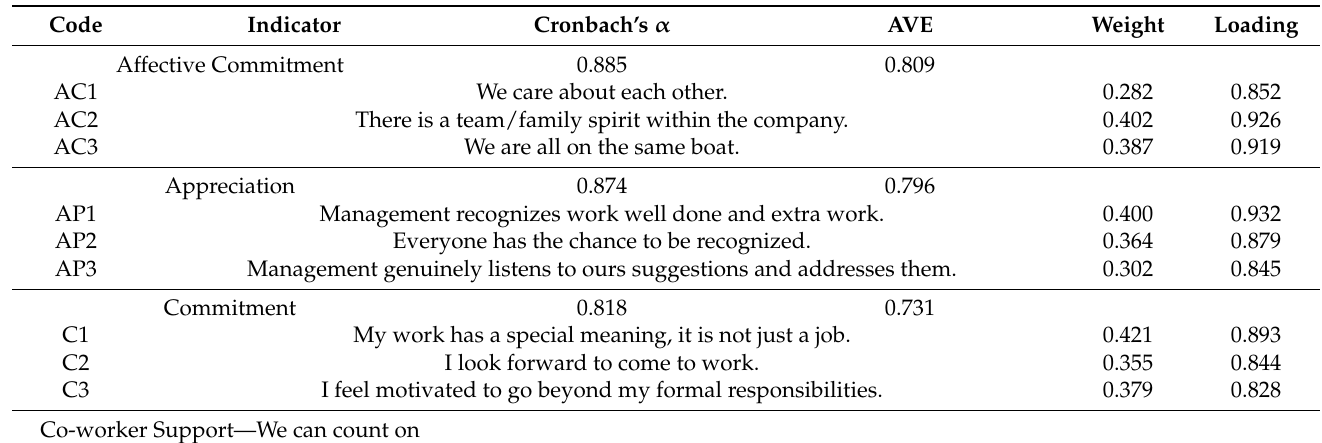
Table 1. Indicators and latent